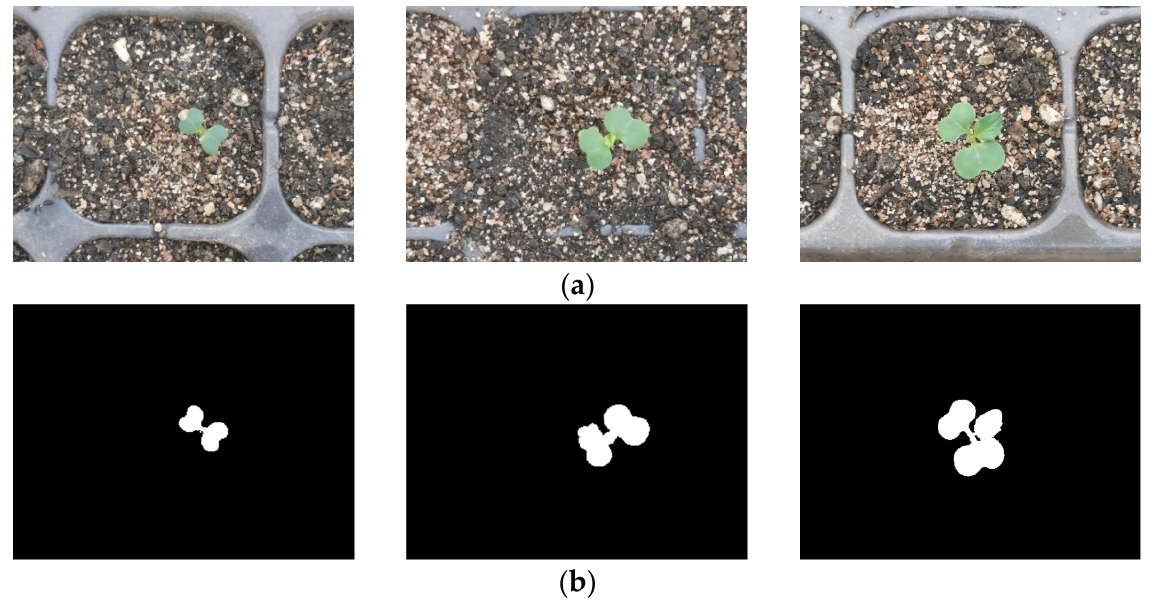
Figure 1. Original wucai seedling image and annotated image. ( a ) Original wucai seedling image samples with different scales; ( b ) annotated image.